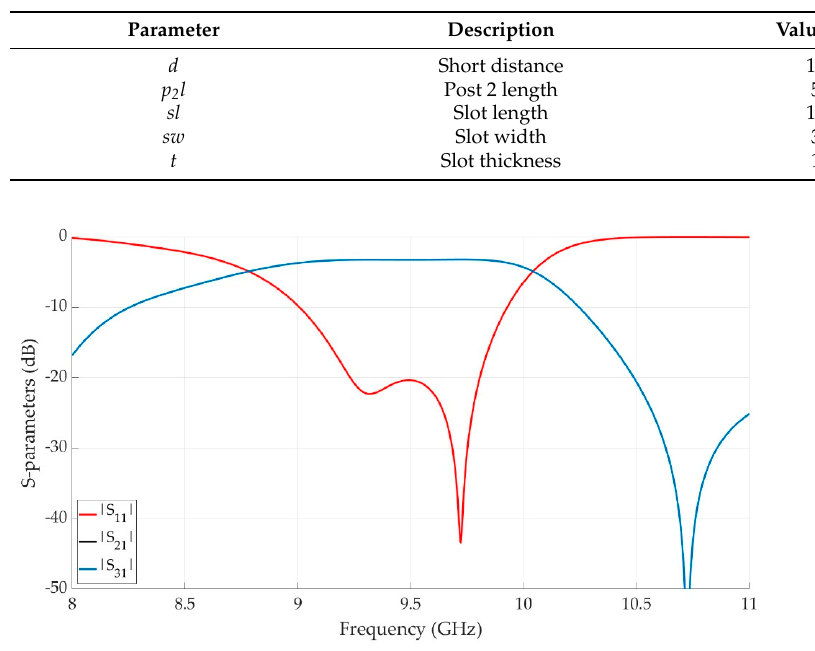
Figure 8. E-plane T-junction scattering parameters. S 21 and S 31 are identical.